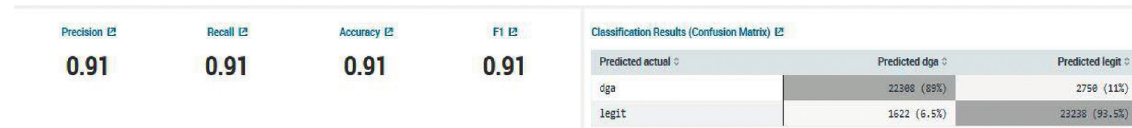
Figure 11: Value evaluation results based on the SVM algorithm without using the principal component analysis feature.